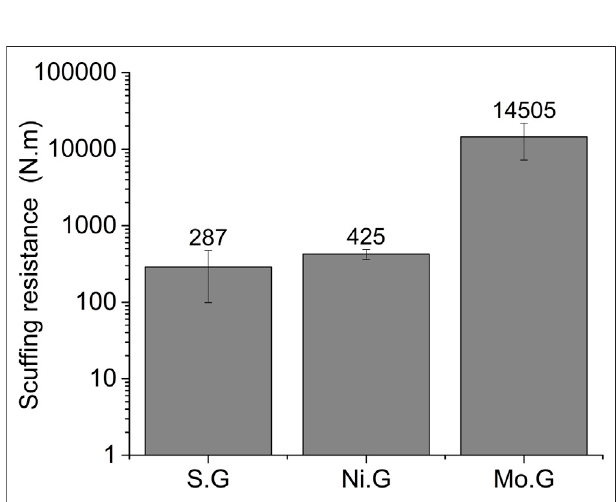
FIGURE 7 | Evolution of the COF and the normal load with the sliding distance.